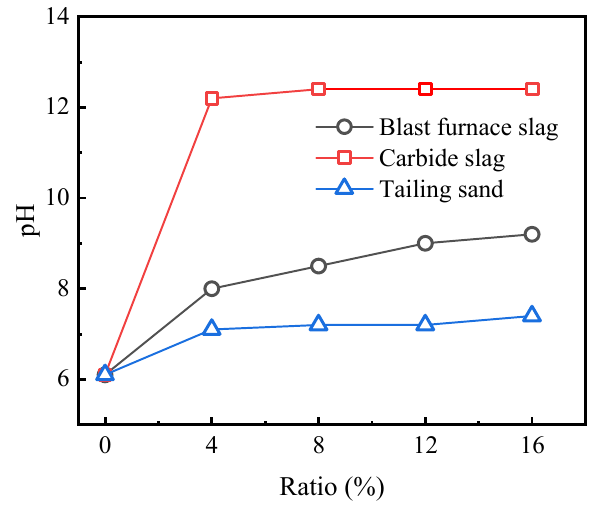
Figure 4. pH of different waste residues soils.